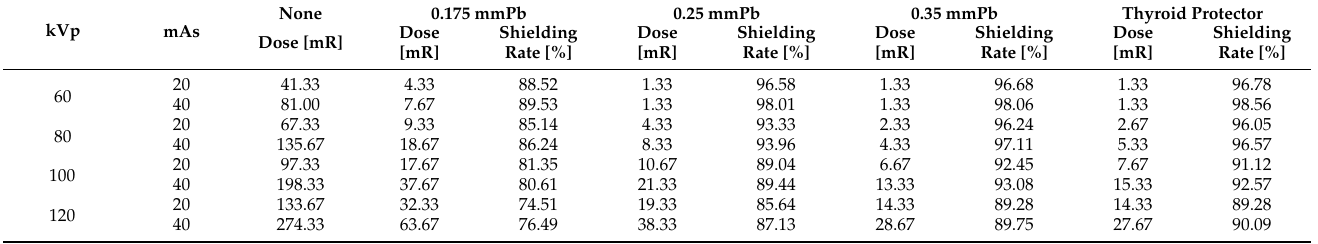
Table 5. X-ray results for radiation apron, thyroid protector tests (60, 80, 100, 120 kVp, 20, 40 mAs).